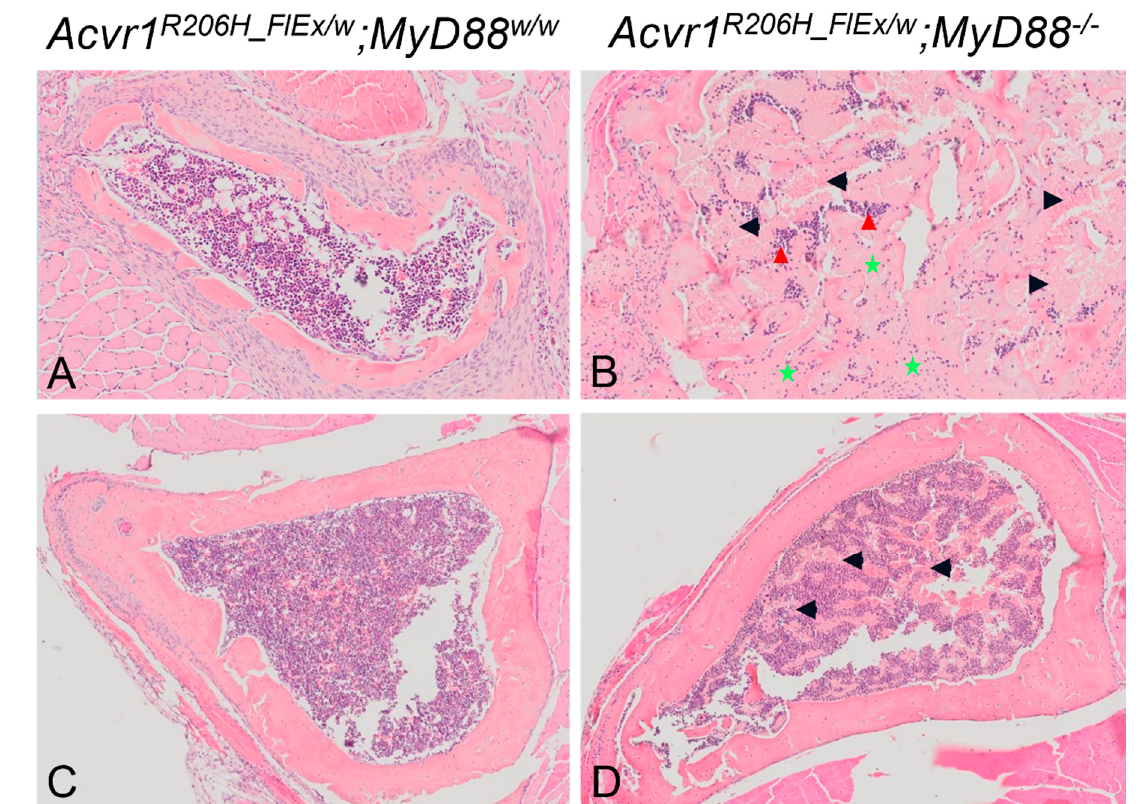
Figure 5. Representative H&E-stained sections of intramuscular EHO lesions and host tibias in Acvr1 R206H_FlEx ;Myd88 w/w and Acvr1 R206H_FlEx ;Myd88 − / − FOP mice 21 dpi. Images are representative micrographs of intramuscular EHO lesions ( A , B ) and host tibias ( C , D ) in the same sections of decalcified paraffin embedded sections stained with H&E. ( A ) A typical mature ossicle of EHO in the hindlimb muscle of an Acvr1 R206H_FlEx ;Myd88 w/w mouse. While most EHO ossicles in Acvr1 R206H_FlEx ;Myd88 − / − mice were similar to that shown in panel A, some ossicles in Acvr1 R206H_FlEx ;Myd88 − / − mice exhibited a disorganized structure ( B ). Note the striking differences in bone organization and soft tissue composition inside the ossicles, including the presence of dysplastic immature immune cells (red arrow heads), excessive erythropoiesis (black arrows), and areas of extracellular matrix accumulation (green stars). ( C , D )—Lox magnification images of tibiae adjacent to the lesions in ( A , B ), illustrating bone marrow composition similar to that of the respective EHO.